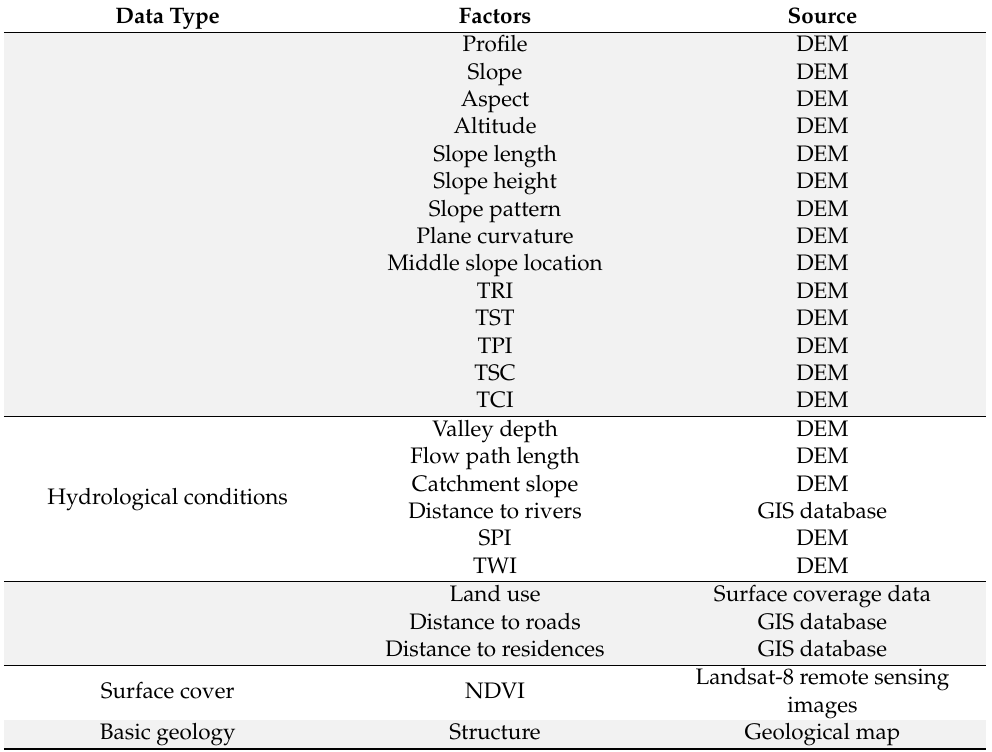
Table 1. Descriptions of the causative factors of